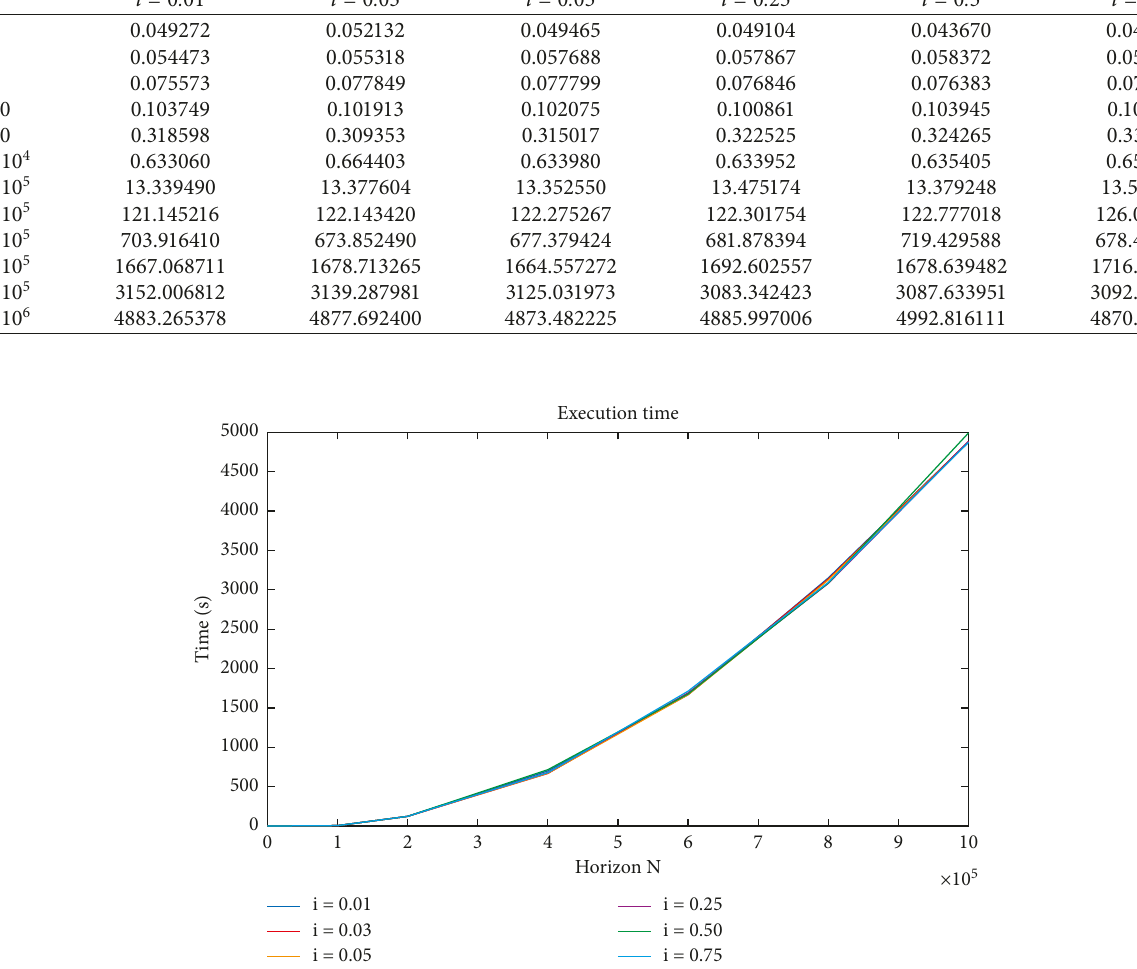
10 6 with c 0 . × (cid:31)